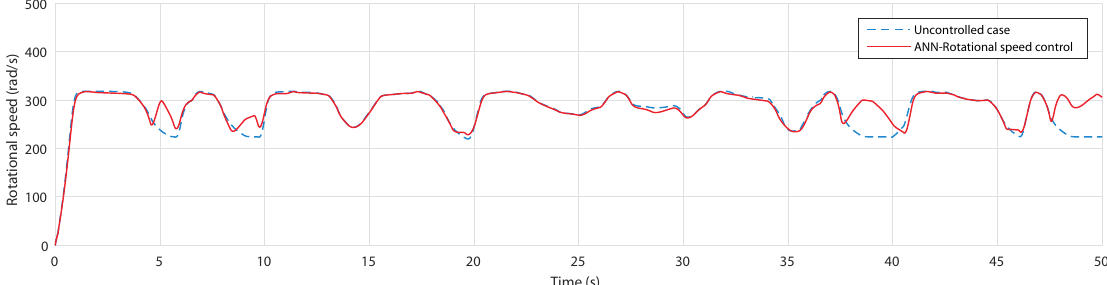
Figure 27. Rotational speed for uncontrolled case and ANN-based rotational speed